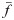
Predictions of the FM-feedback spectral model for sweep trains.A) Heatmaps show the distribution of the activation across the spectral representation (y-axis are cochlear channels) for different sweep frequency spans Δf (x-axis). Error bars point to the expected value and standard deviation of the distribution across frequencies for each sweep. Each empty square denotes the expected channel elicited by a pure tone with the frequency of the average experimental data of the corresponding sweep. B) Predictions of the standard deviation of the perceived pitch. Error bars are estimations of standard error of the model calculated based on the dispersion of the centroids for different f‾ and the standard deviations of the spectral distribution ρ of each condition. Kernel density estimations show the empirical subjects’ standard deviation of the sweep pitch shift Δp in sweep trains, plotted separately for the different frequency spans Δf. Each sample in the distributions corresponds to the standard deviation of the perceived pitch of a sweep in one subject. The standard deviation is monotonically correlated to the absolute span |Δf| (rs = 0.63, p < 10−27). C) Predictions of the standard deviation and up/down asymmetry. Error bars show the model predictions of the up/down asymmetry coefficient asymm↑↓ (see Eq (1)) in the channel space. Kernel density estimations show the empirical up/down asymmetry distributions in sweep trains, as defined in Eq (1). Each sample of the distributions corresponds to the difference of the average absolute deviation from centre frequency between up and down sweeps of the same |Δf| for a given subject and centre frequency. Red crosses show the mean and the standard error of the data.